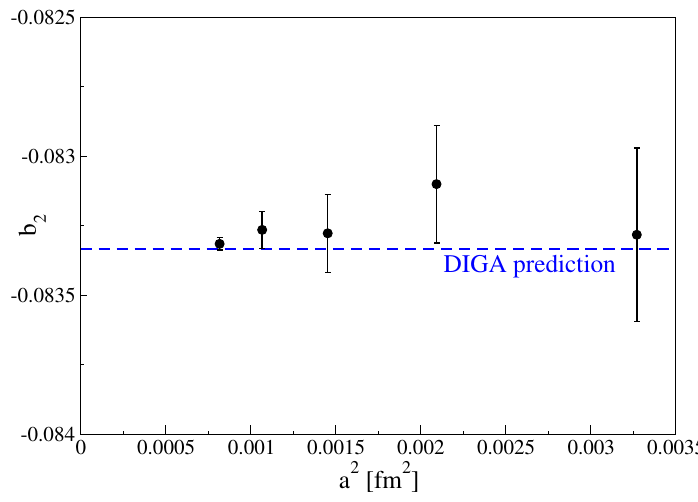
Figure 13 . Numerical results obtained for the coe(cid:14)cient b 2 , as a function of a 2 , for T ’ 430 MeV. The horizontal line represents the prediction of the dilute instanton gas approximation